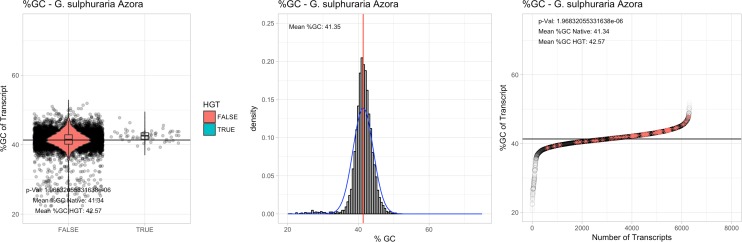
Galdieria sulphuraria Azora: (Left) Violin plot showing the %GC distribution across native transcripts and HGT candidates.(Mid) Cumulative %GC distribution of transcripts. Red line shows the average, blue line a normal distribution based on the average value. (Right) Ranking all transcripts based upon their %GC content. Red ‘*' demarks HGT candidates. As the %GC content was normally distributed, students test was applied for the determination of significant differences between the native gene and the HGT candidate subset.